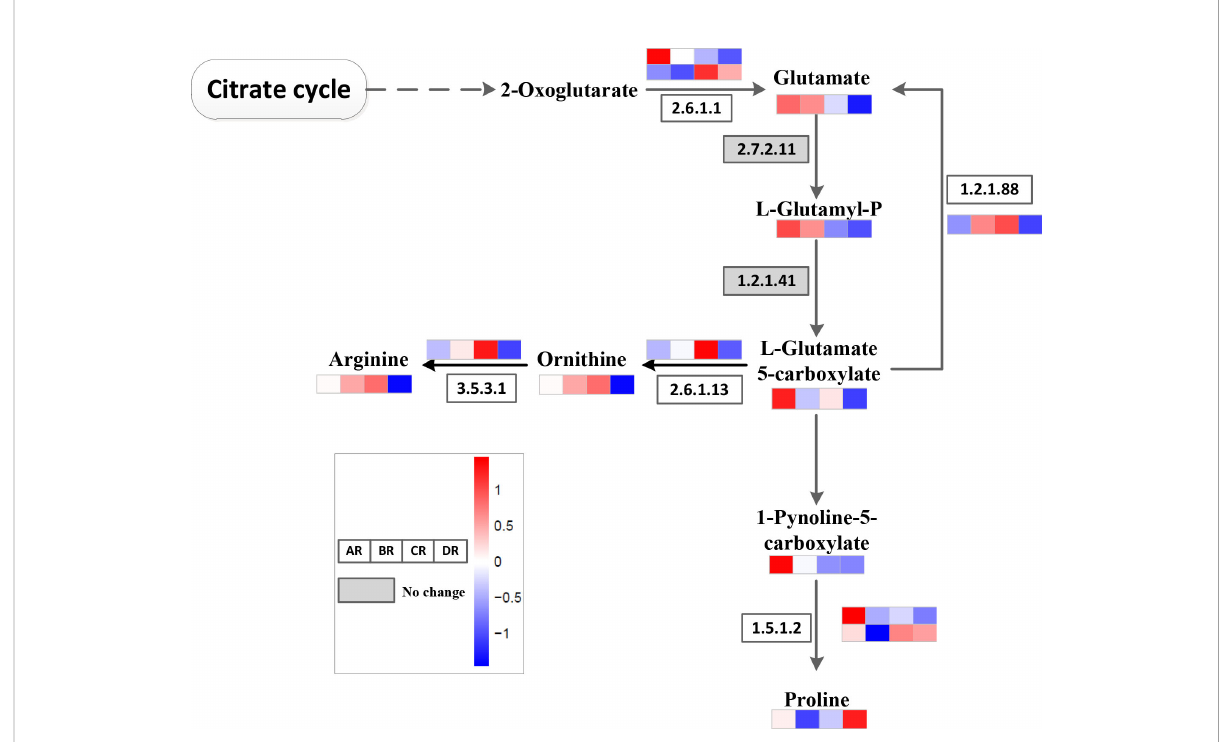
FIGURE 8 Changes of gene expression and metabolic level involved in the arginine and proline